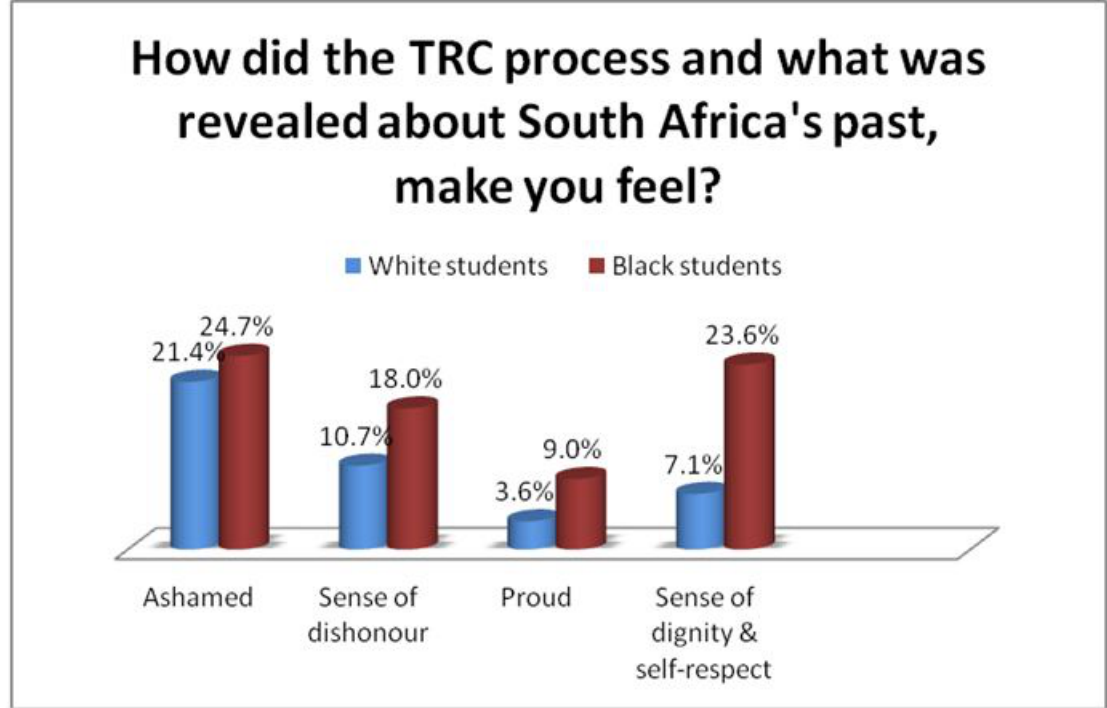
Figure 2: Black and White students’ outlook towards the TRC